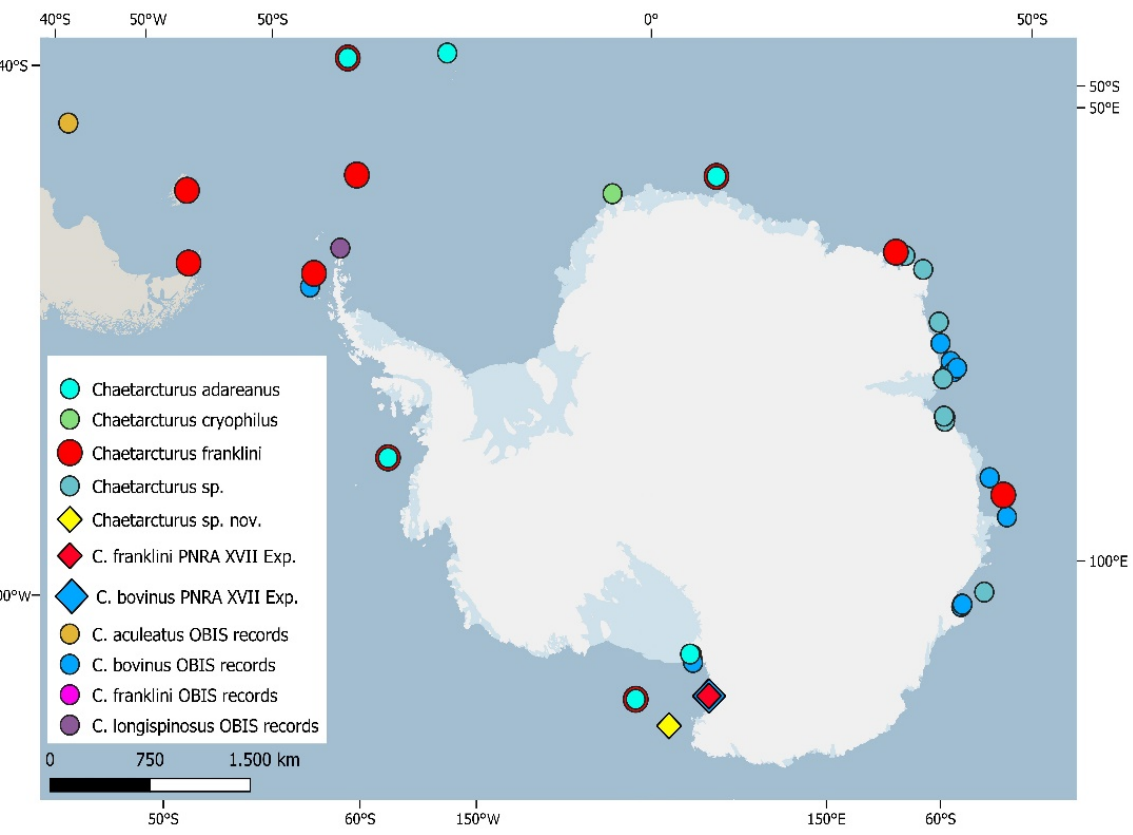
Figure 1. Distribution records of Chaetarcturus Brandt, 1990 species in Southern Ocean, using GBIF and OBIS database and MNA unpublished data. GBIF and OBIS database data are represented by dots, squares stand for Chaetarcturus species recorded during the PNRA XVII Italian Expedition 2001/02, blue and red for C. bovinus (Brandt & Wägele, 1988) and C. franklini (Hodgson, 1902) respectively. Record of C. cervicornis sp. n. is marked with a yellow square.